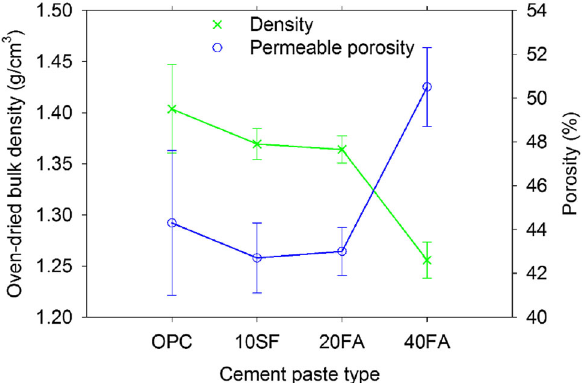
Fig. 1 Bulk densities and porosities of the cement pastes after oven drying (the error bars indicate ± one standard